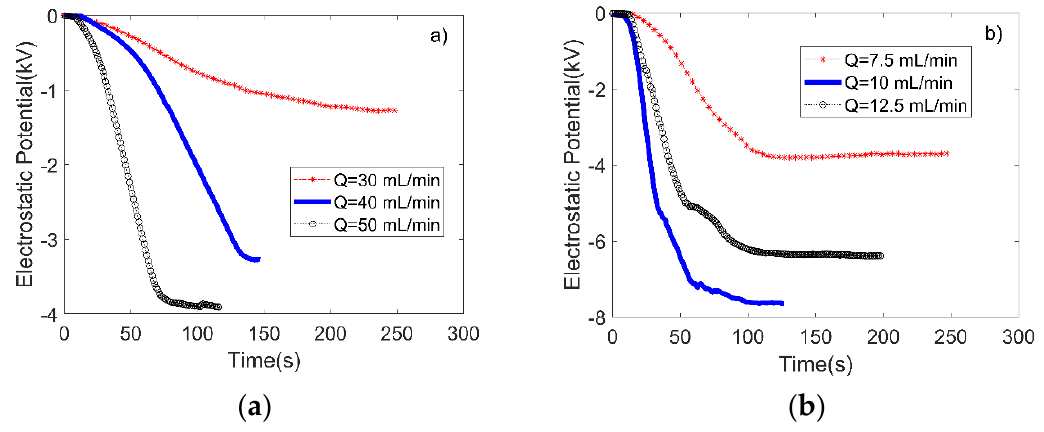
Figure 3. Output voltages of the negative electrodes of two MKWDs over a period up to 250 s. ( a ) and ( b ) represent the results from the MKWDs with microchannel IDs of 508 µm and 254 µm, respectively. The calculated average flow speeds were 2.517 (red), 3.356 (blue), and 4.195 (black) m/s for both MKWDs.